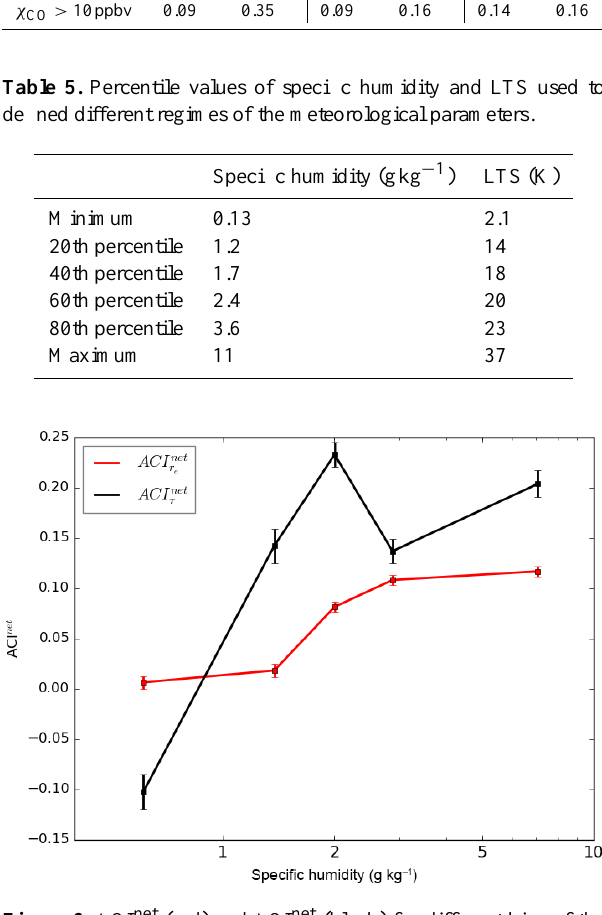
Figure 6. ACI net r (red) and ACI net τ (black) for different bins of the e specific humidity, stratified by LTS between 17 and 22K. Each marker is placed in the middle of the corresponding